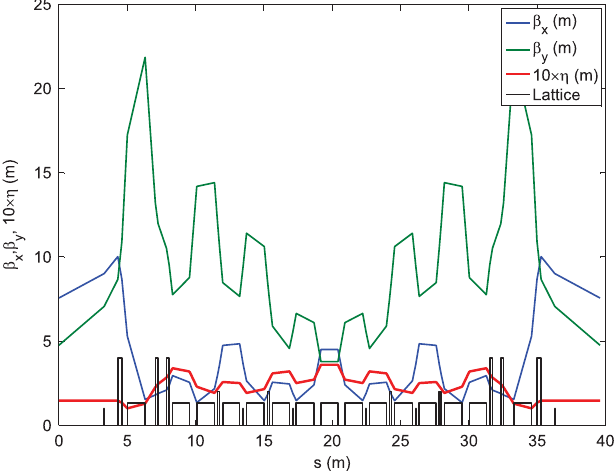
FIG. 1. (cid:2) and dispersion functions for one-quarter of the NSLS-II booster.